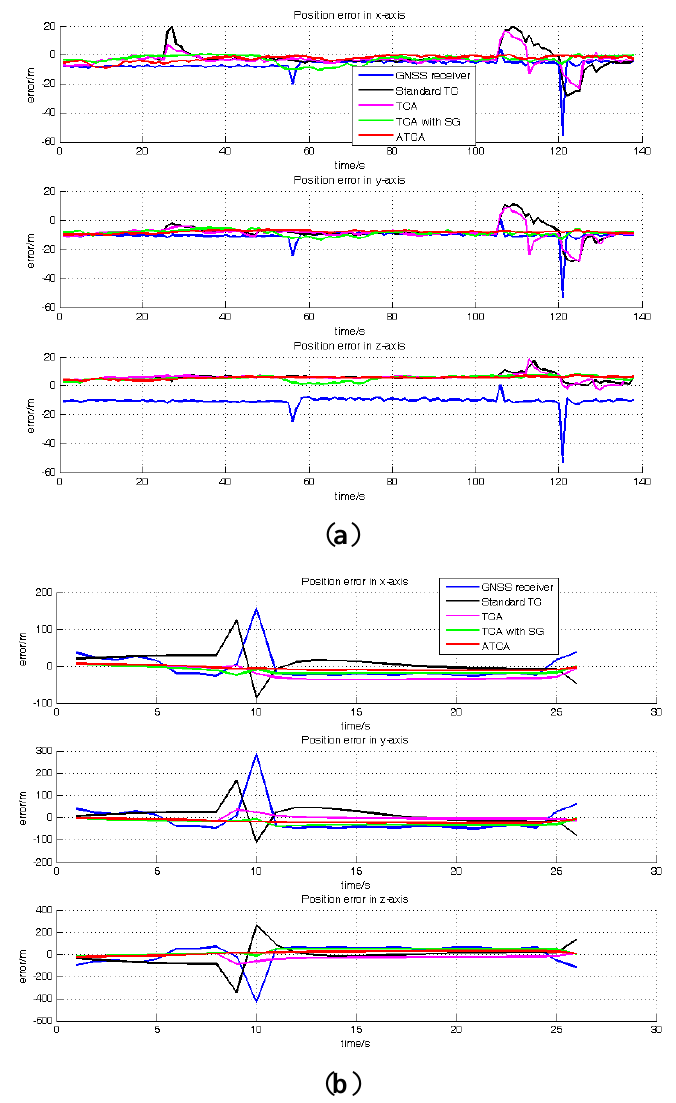
Figure 11. Position error comparisons: ( a ) position errors of GNSS receiver, standard TC, TCA, TCA with SG and ATCA in the ECEF frame during the periods of 50 s and 187 s; ( b ) position errors of the GNSS receiver, standard TC, TCA and ATCA in the ECEF frame during the periods of 673 s and 698